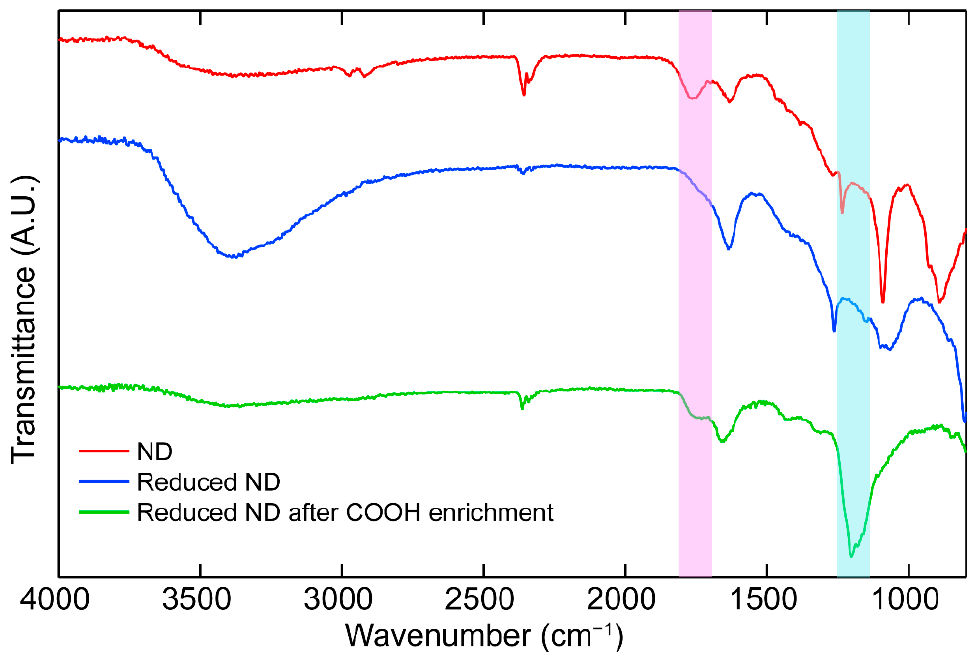
Figure 1. FTIR spectra of detonation nanodiamonds through the carboxylic acid enrichment proce- dure. The spectra correspond to untreated nanodiamonds (red line), nanodiamonds reduced with LiAlH 4 (blue line), and LAH reduced nanodiamonds following carbenoid insertion and subsequent ester cleavage (green line). The pink area highlights the C=O stretch at ~1750 cm − 1 , whereas the blue area highlights the C-O stretch associated with the ether bond at ~1200 cm − 1